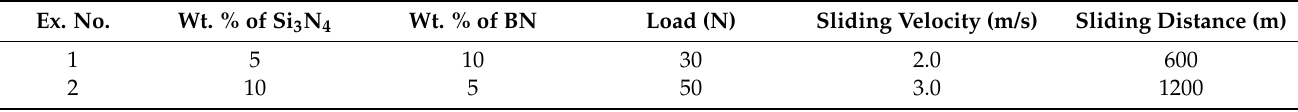
Table 8. Input parameters of confirmation